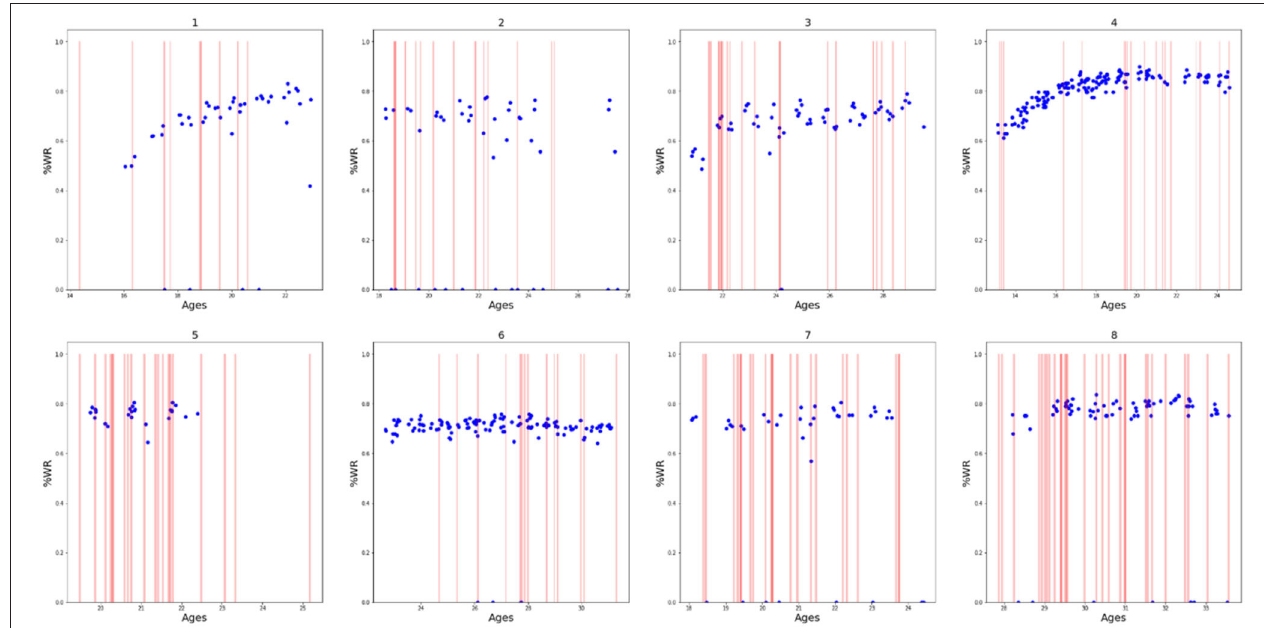
FIGURE 1 | Evolution of the performances (represented by the percentage of the World Record, in blue dots) for each included athlete over time (represented by the athlete’s age) with occurrence of injuries (in red vertical line). The meaning of numbers (1–8) are the number of each athlete of the study.